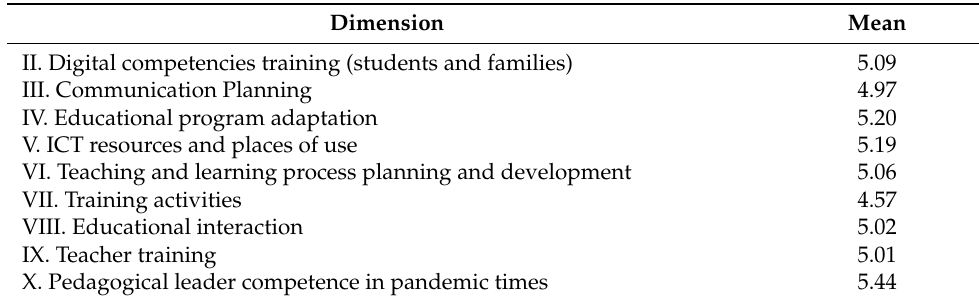
Table 3. Means obtained by questionnaire dimensions.